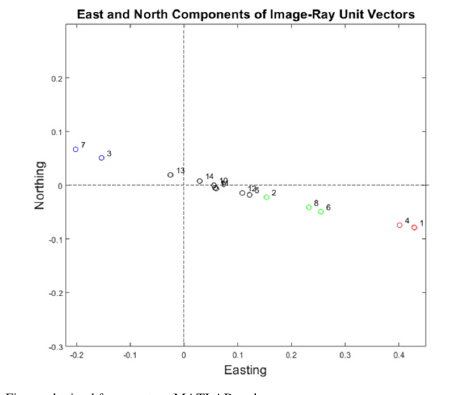
Figure 3. Image chips containing a GCP